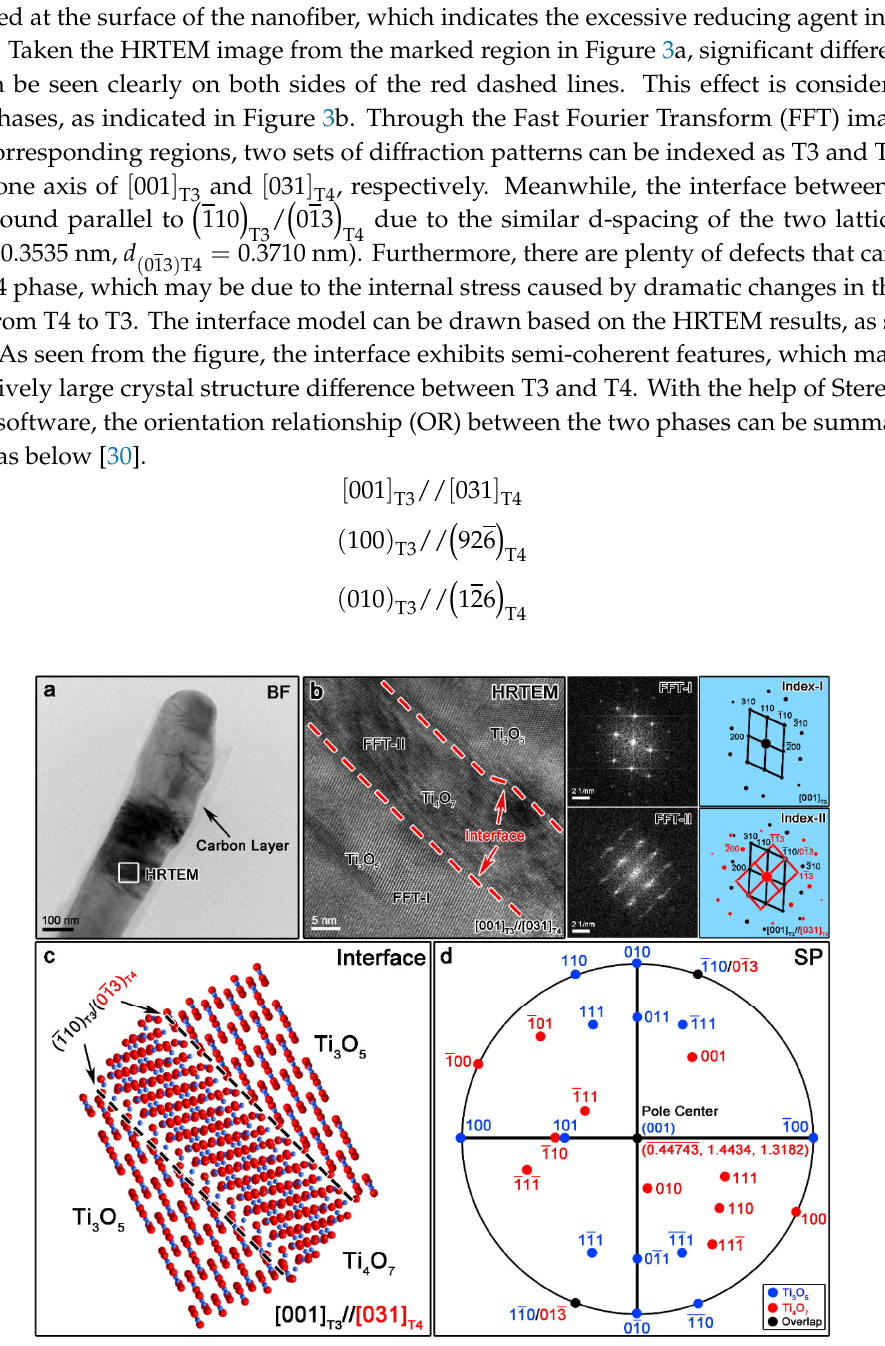
Figure 3. The TEM Bright Field (BF) ( a ) and HRTEM image ( b ) of one T4 / T3 dual-phase nanofiber suggest the existence of the carbon layer and the semi-coherent nature of the interface. The interface structure model ( c ) and stereographic projection diagram of planes ( d ) also illustrate the detailed interface crystallographic